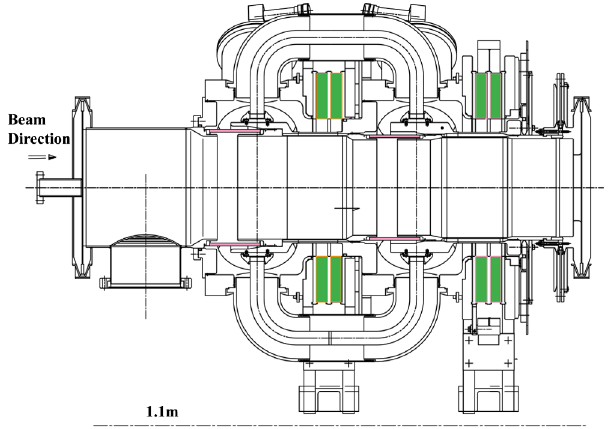
FIG. 23. Side view of planned ferrite-loaded rf